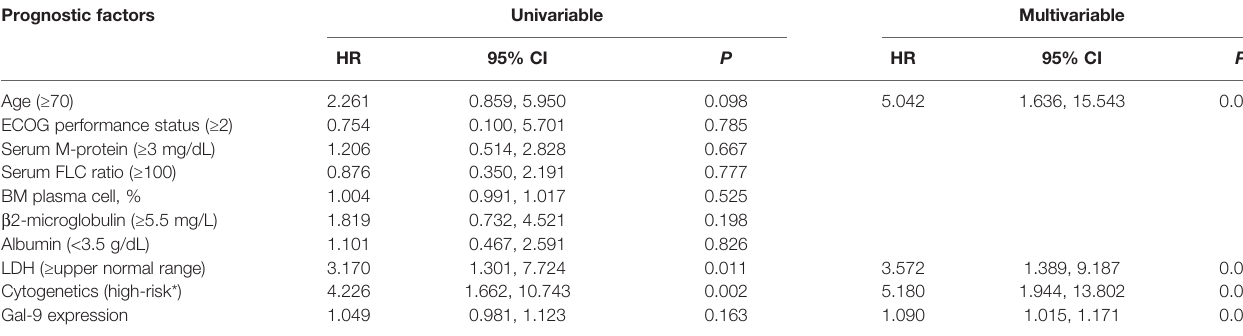
TABLE 3 | Univariable and multivariable analyses of OS in the high PD-L1 expression group. Prognostic